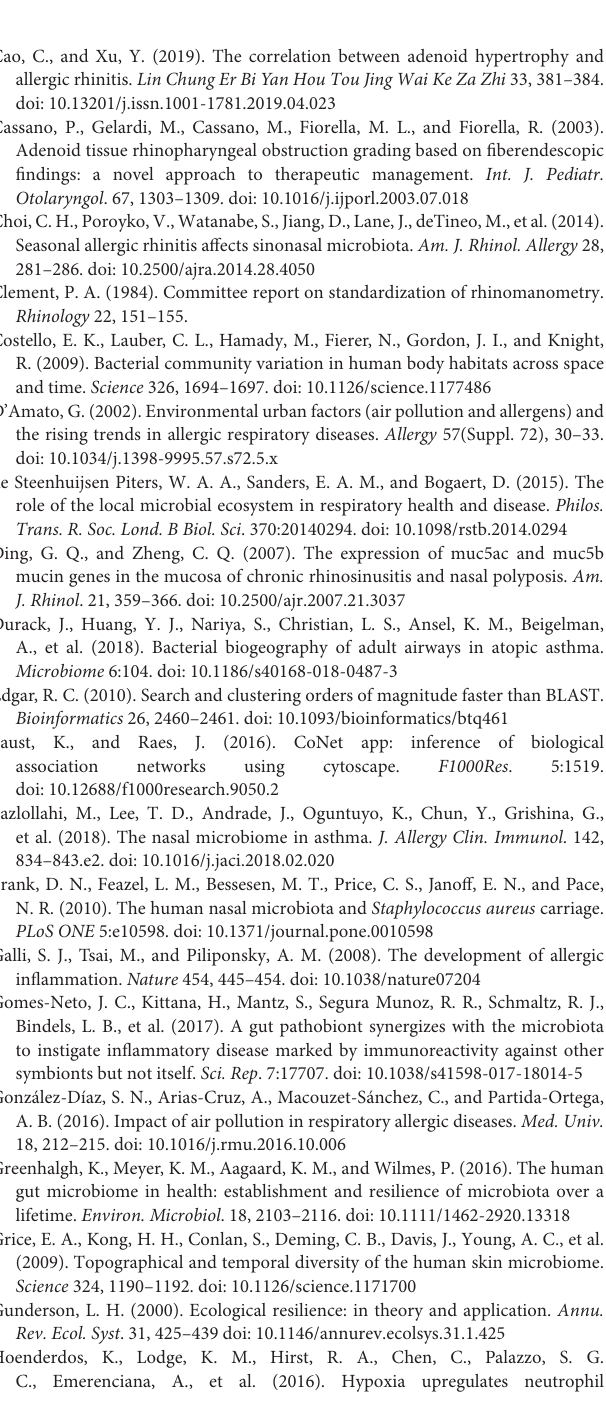
confidence interval at 95% (CI95%) and the statistical significance respect to the random classifier ( p -value) were reported. Table S2 | Detailed information about the analysis of important nodes in computed microbial networks. For each node, the number of degrees, the percentage of maximum number of degrees among all networks and the node classification were reported. N/P taxa not present in the